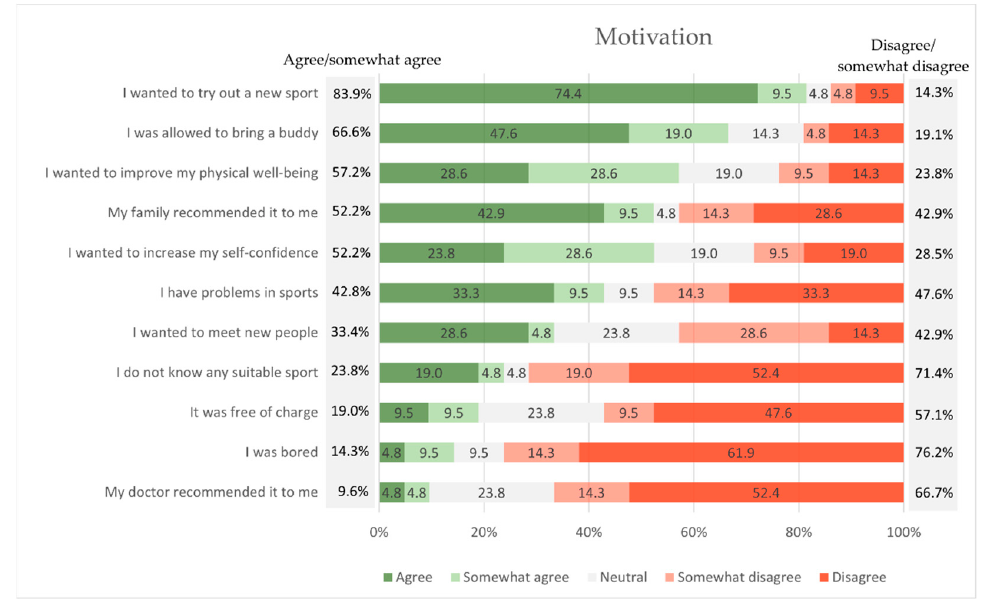
Figure 3. Motivation to exercise participation in the outdoor exercise program. After the try-out days, participants reported that they were in a good mood (100%), satisfied (94.7%), happy (89.5%), and self-confident (89.5%) (Figure 4). Moreover, they had no pain (100%) and did not feel listless (94.7%) or disappointed (94.7%). After the active weekend camps, participants stated that they were happy (100%), satisfied (92.9%), and in a good mood (92.9%). Furthermore, they did not feel listless (92.9%), disappointed (92.9%), had no pain (85.7%), or were not glad that it was over (85.7%). Overall, 89.5% and 92.5% of try-out day and active weekend camp participants, respectively, rated the exercise programs as good to very good.